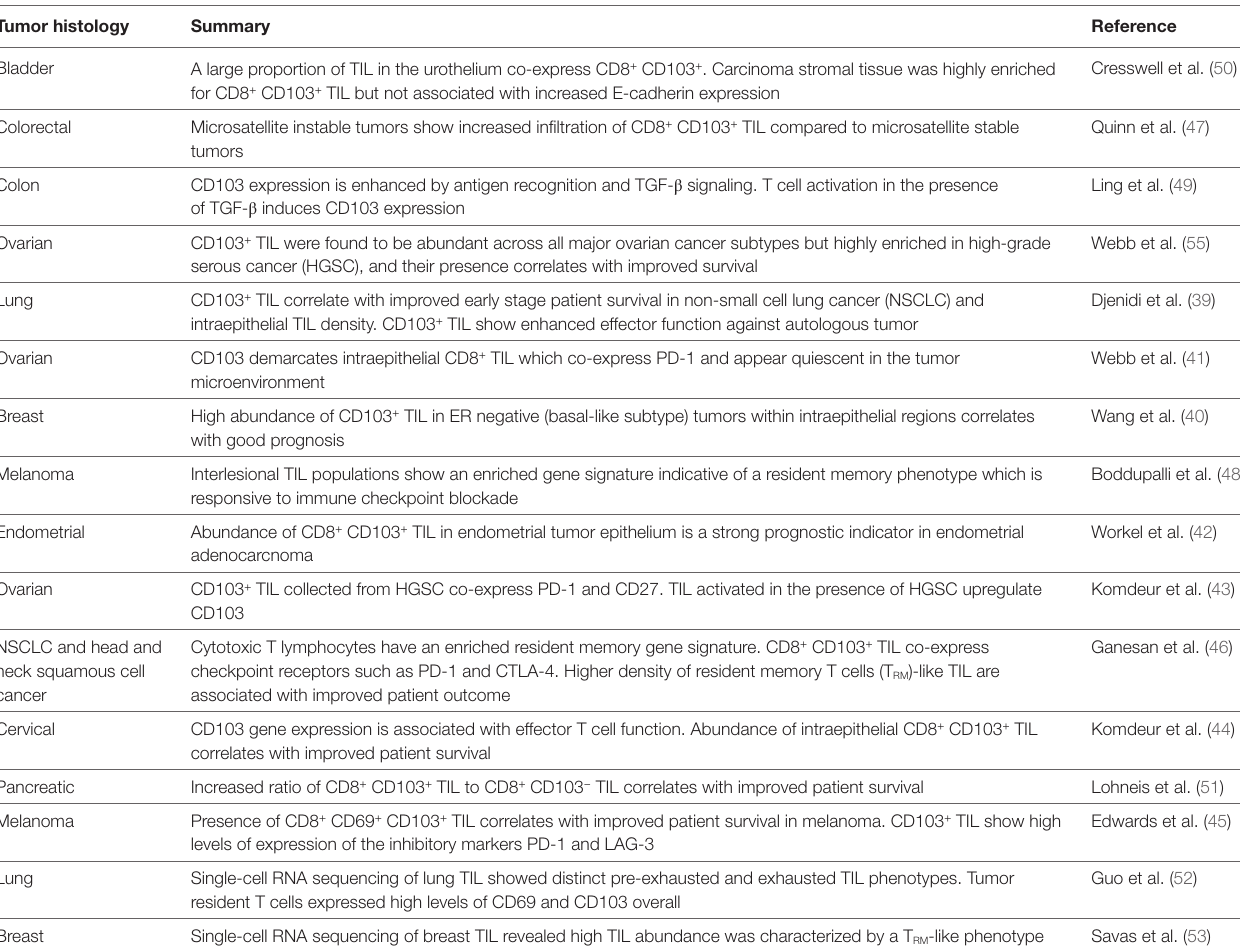
TABLe 1 | Summary of studies examining CD103 + TIL RM as a prognostic indicator in solid